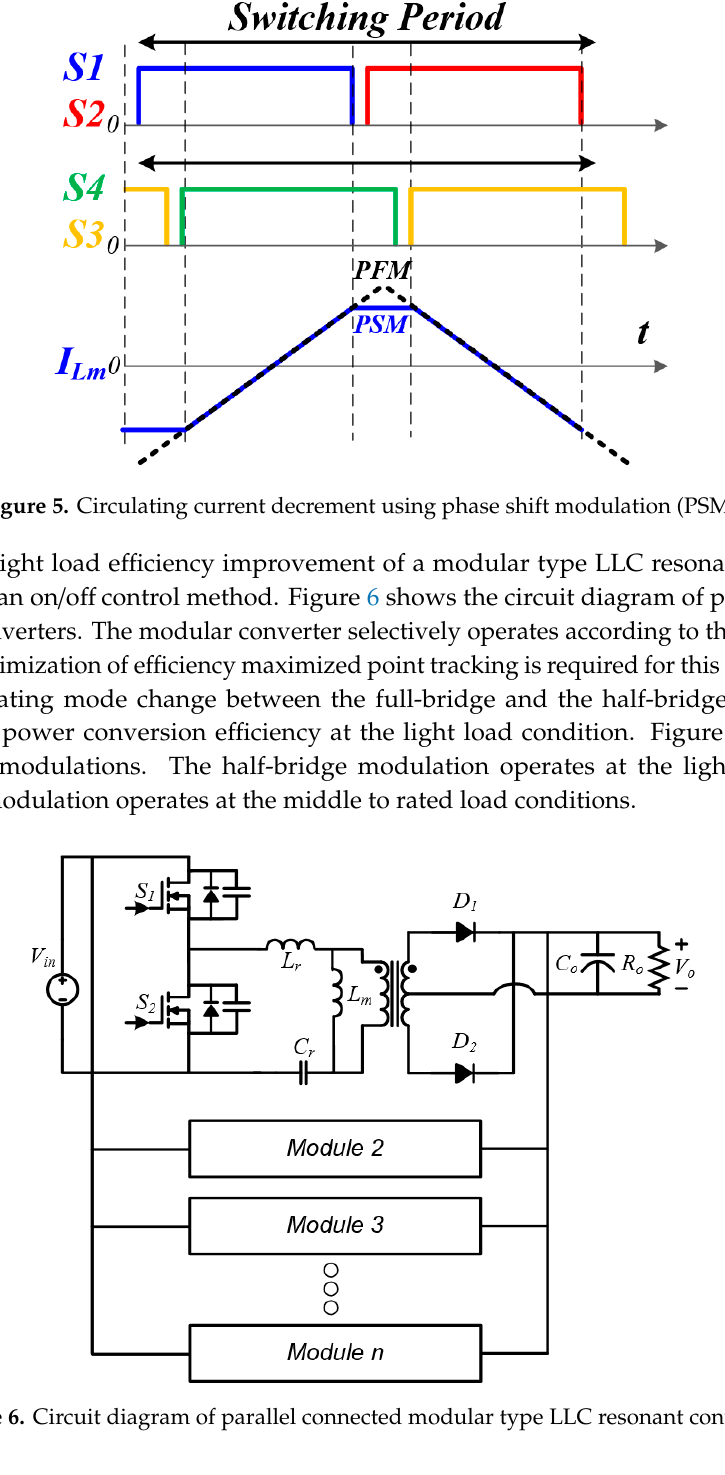
Figure 4. LLC resonant converter with an additional switch and capacitor combination.